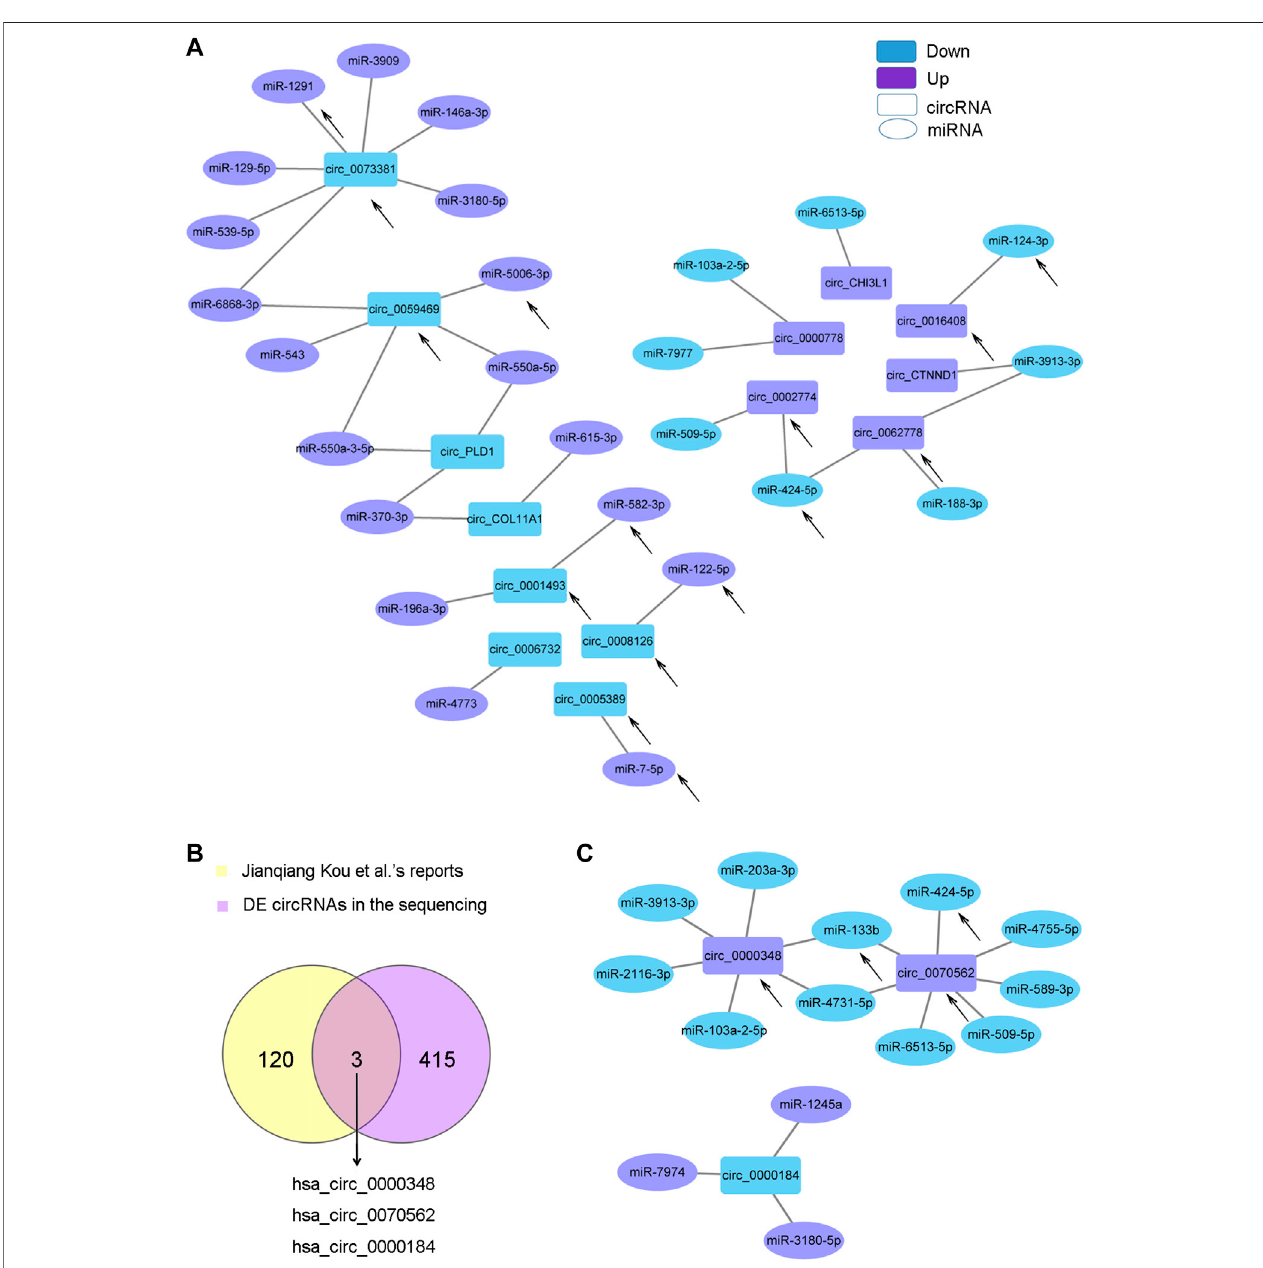
FIGURE 4 | CircRNA-miRNA network. (A) . The circRNA-miRNA network based on the negative correlation of the top 20 DE circRNAs with DE miRNAs. (B) . Venn diagram showing the three key circRNAs identi fi ed by both of our circRNA sequencing and another team. (C) . The circRNA-miRNA network based on the negative correlation of the three circRNAs in (B) with DE miRNAs. The circles indicate miRNAs, and the rectangles indicate circRNAs. Purple nodes indicate upregulated genes, and blue nodes indicate downregulated genes (AS/HD). The edges indicate the interaction between two nodes. The black arrows indicate the key RNAs.